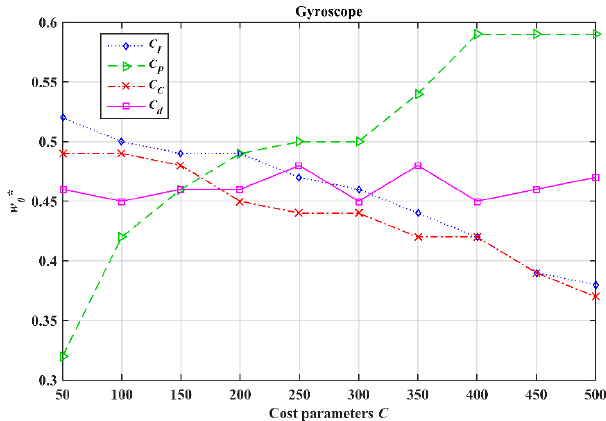
∗ w ∗ . Figure 9. Influence of the cost parameters on the optimal value w 0 0